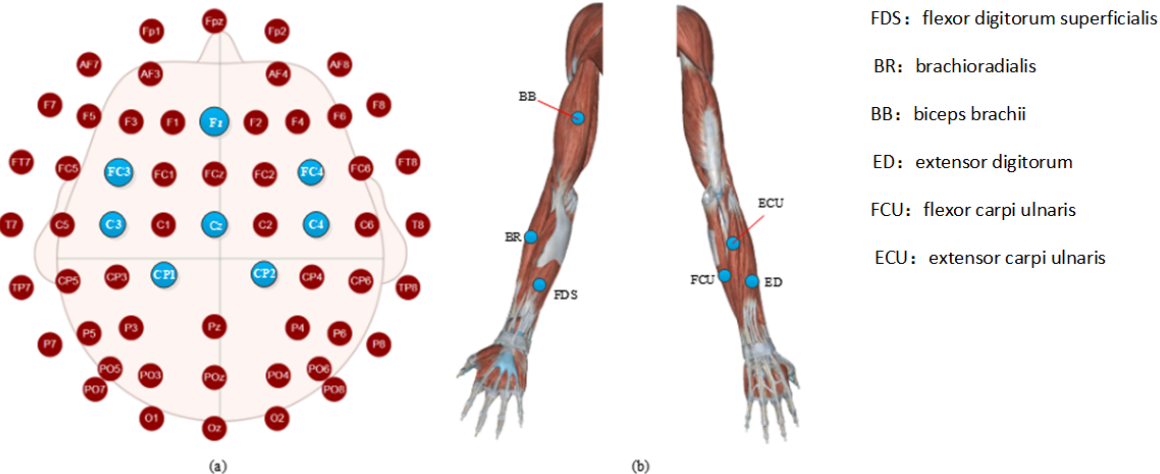
Figure 2. Experimental paradigms. HO: hand open, HC: hand close, WF: wrist flexion, WE: wrist extension.